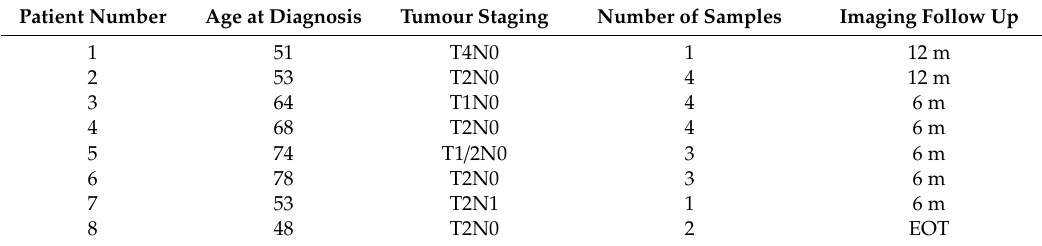
Table 1. Patient